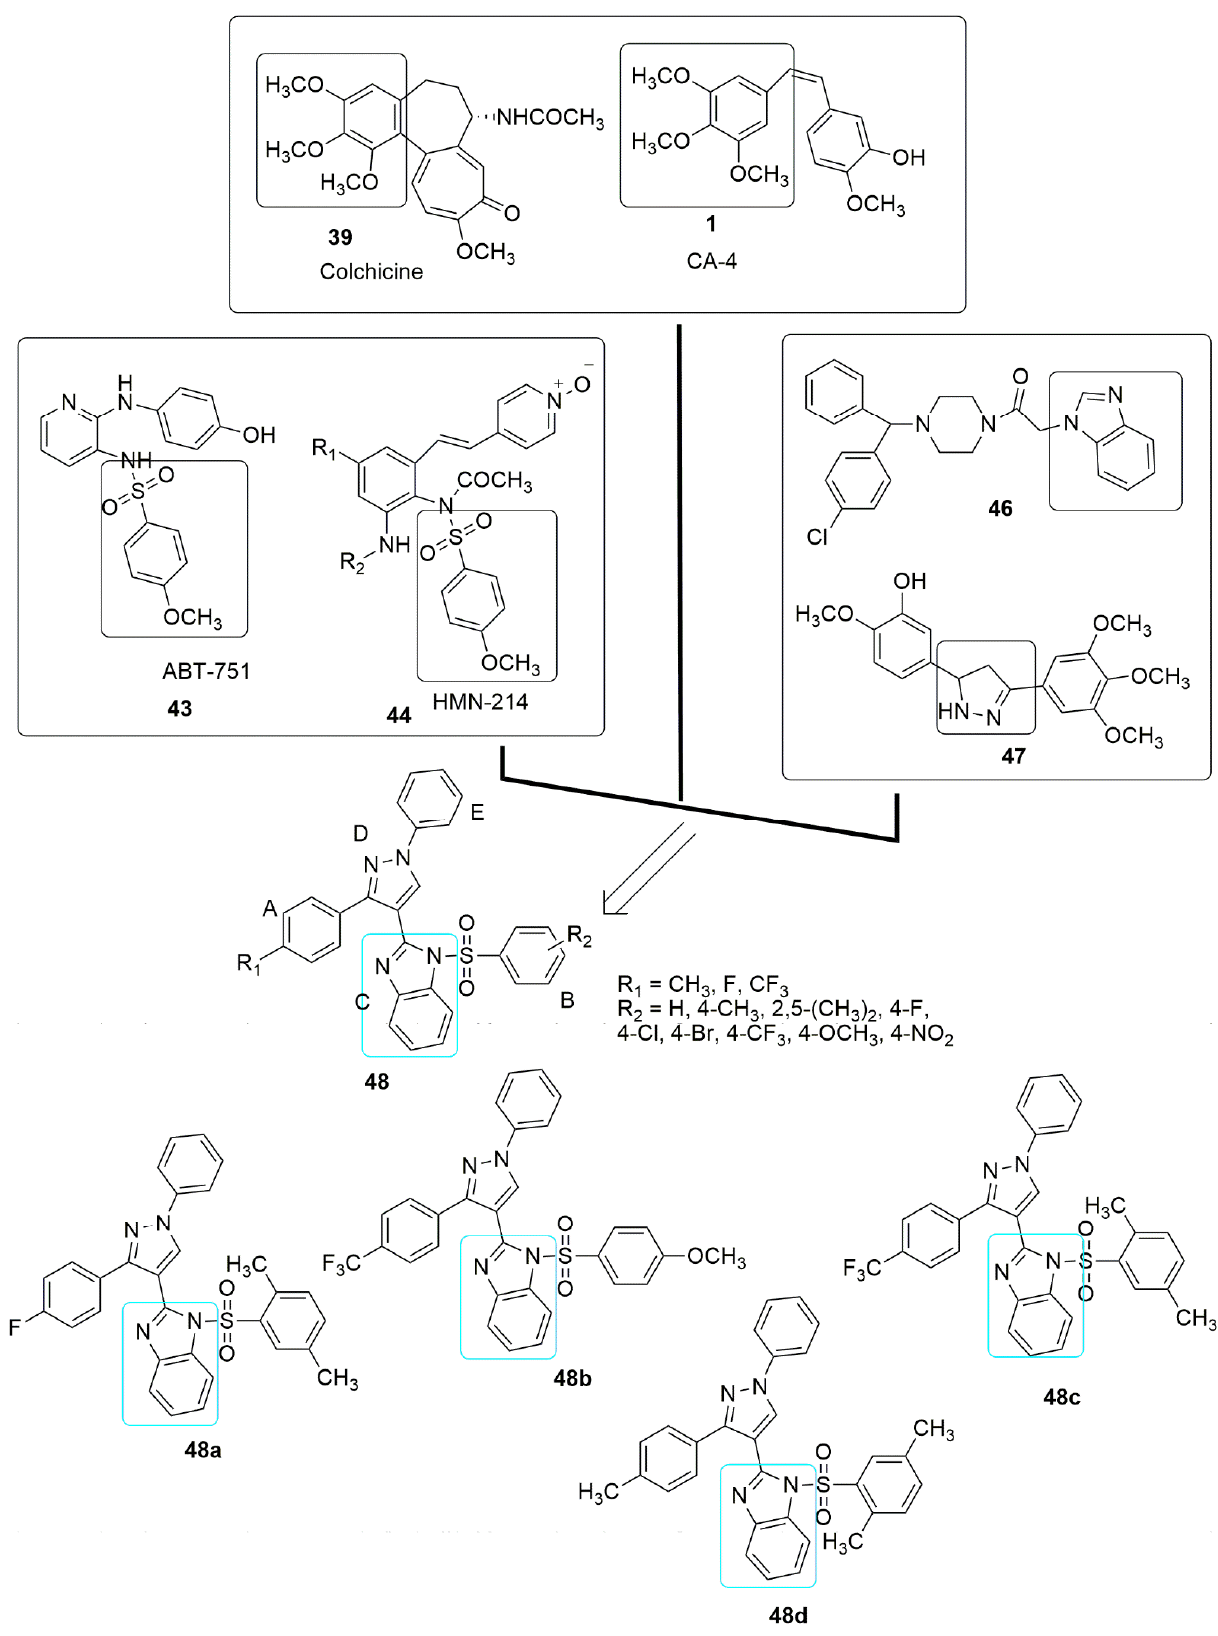
Figure 16. Antiproliferative and anti-tubulin activity of active compounds of benzimidazole conjugates.